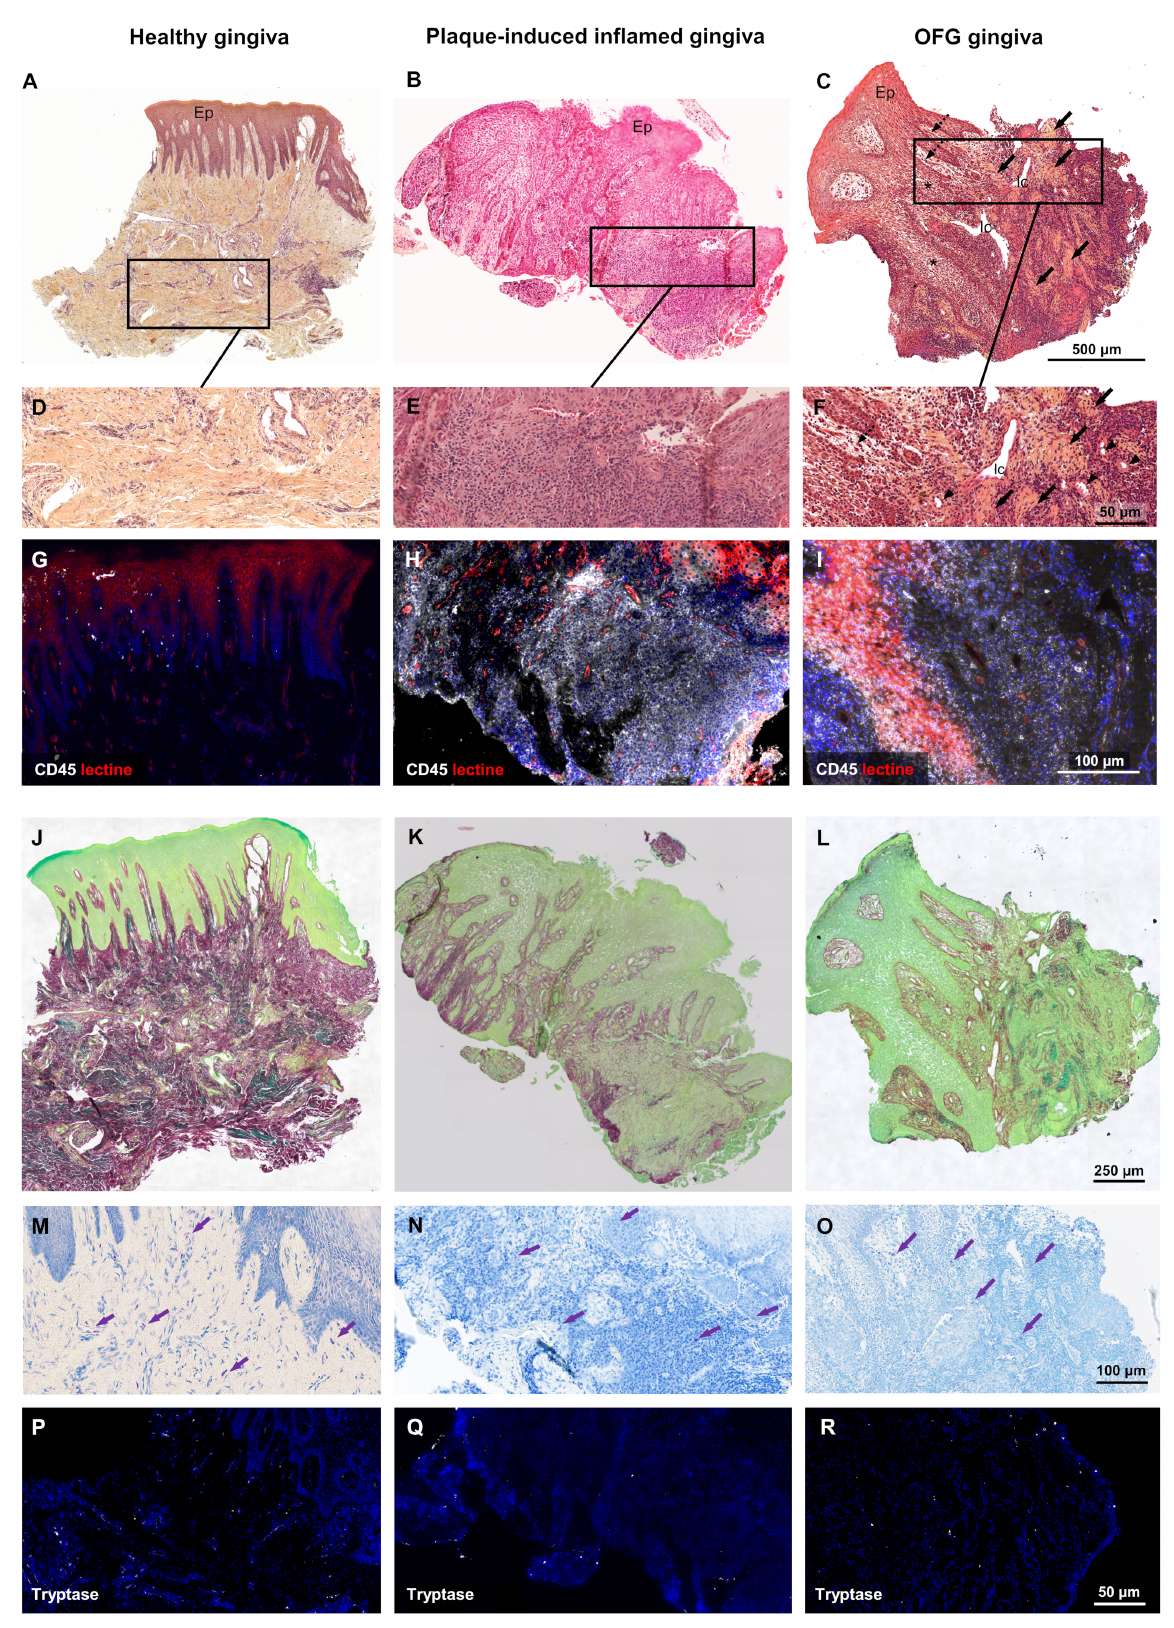
Figure 2. OFG histopathology. Healthy and plaque-induced inflamed gingiva were compared to gingival samples recovered from OFG tissue. The microscopic examination of the OFG tissue